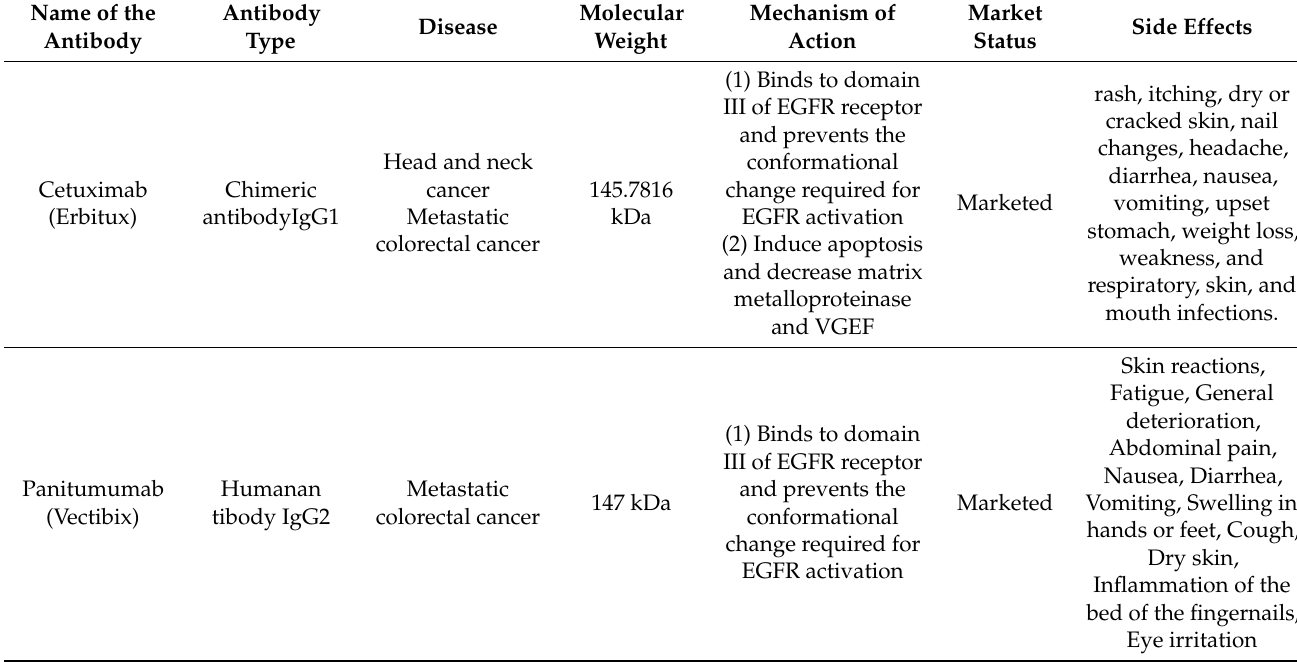
Table 1. List of EGFR monoclonalantibodies used in the treatment of colorectal